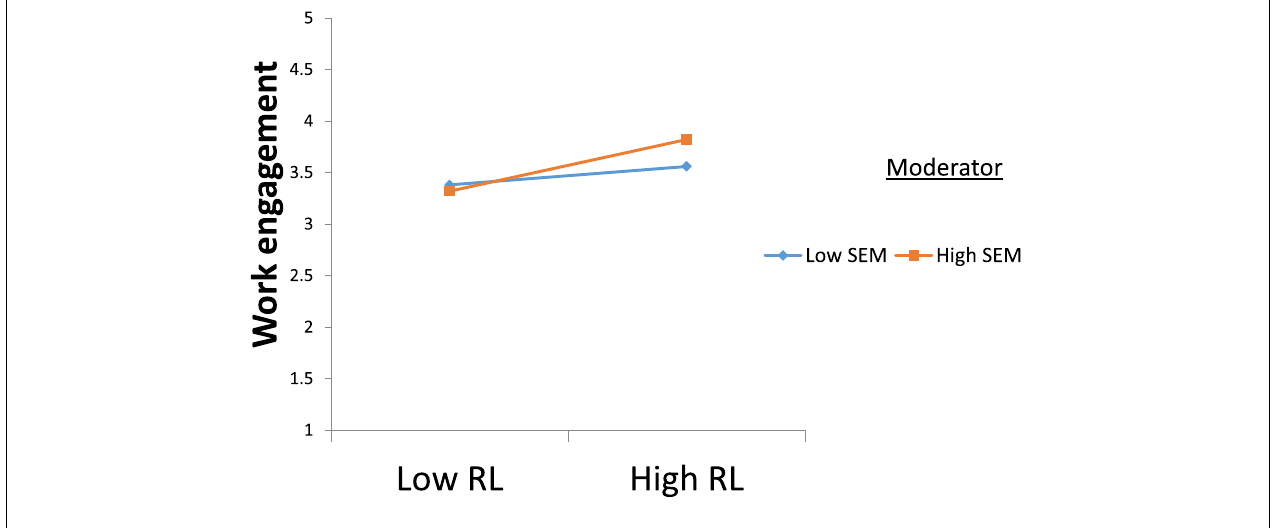
FIGURE 2 | Interaction